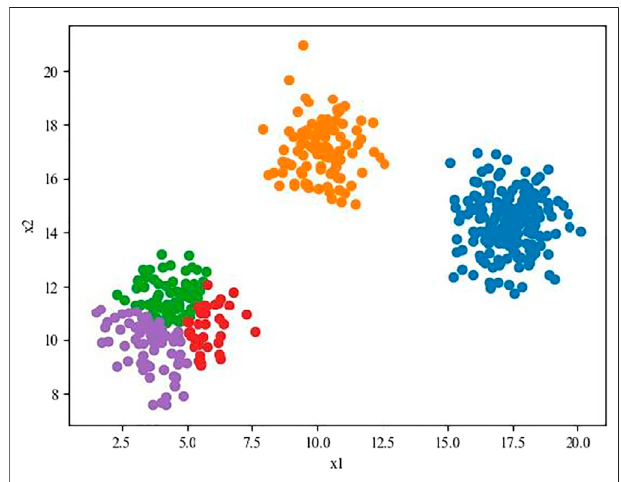
FIGURE 8 | K-means